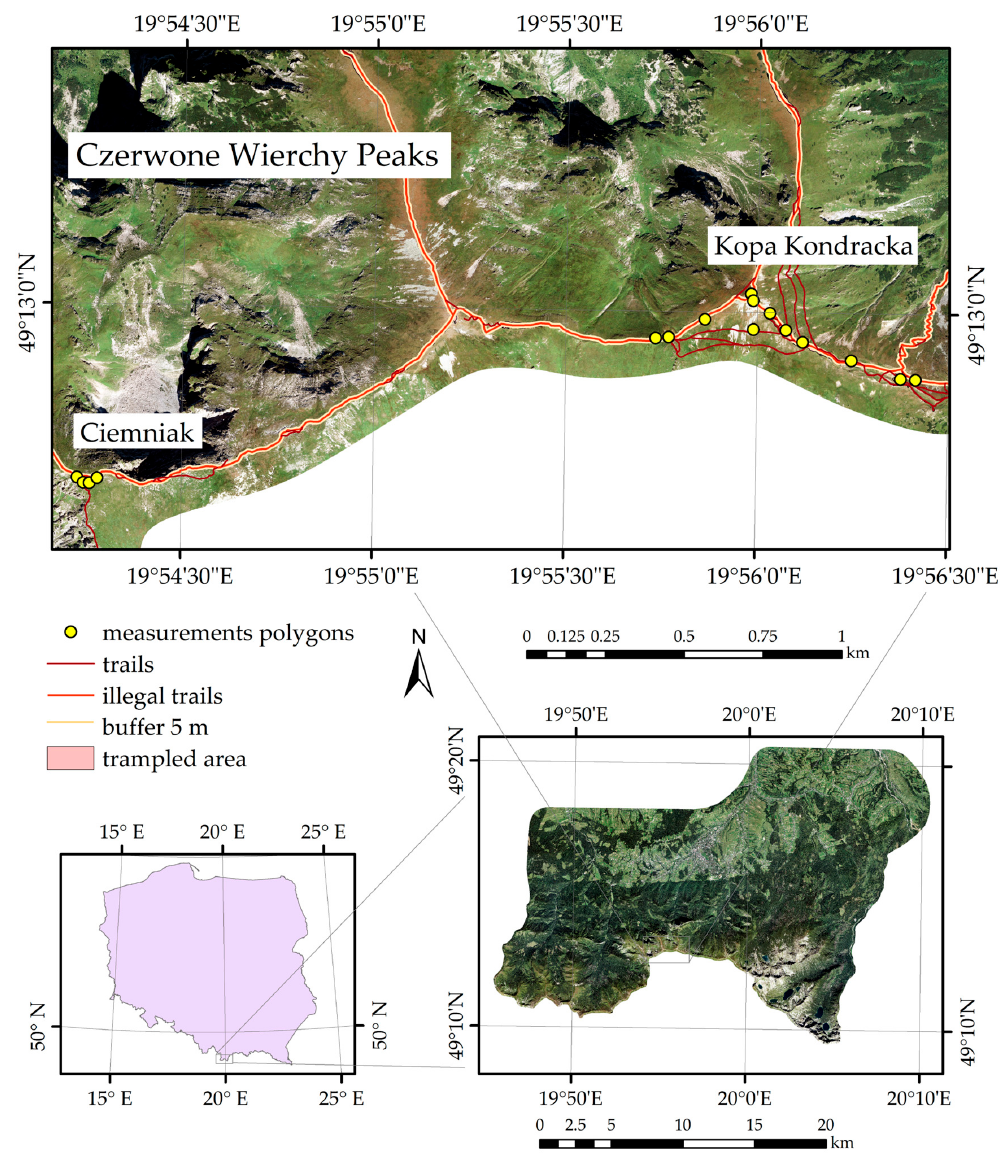
Figure 2. Location of the research area and polygons.